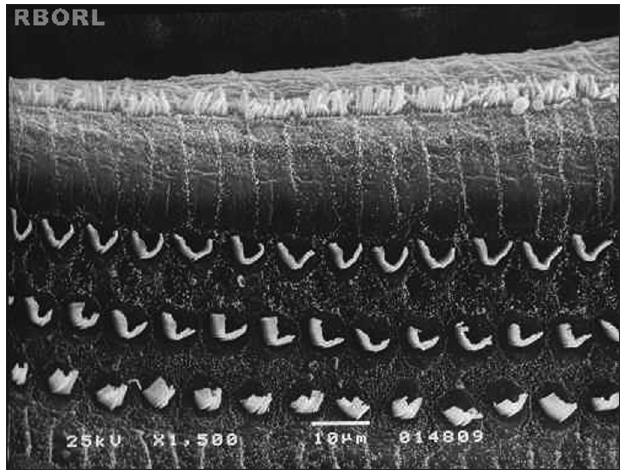
Figura 3. Fotomicrografia de órgão de Corti normal encontrado em cobaia do grupo 3, exibindo espira E2. Observe arranjo normal das células ciliadas externas. Ampliação 1500x.